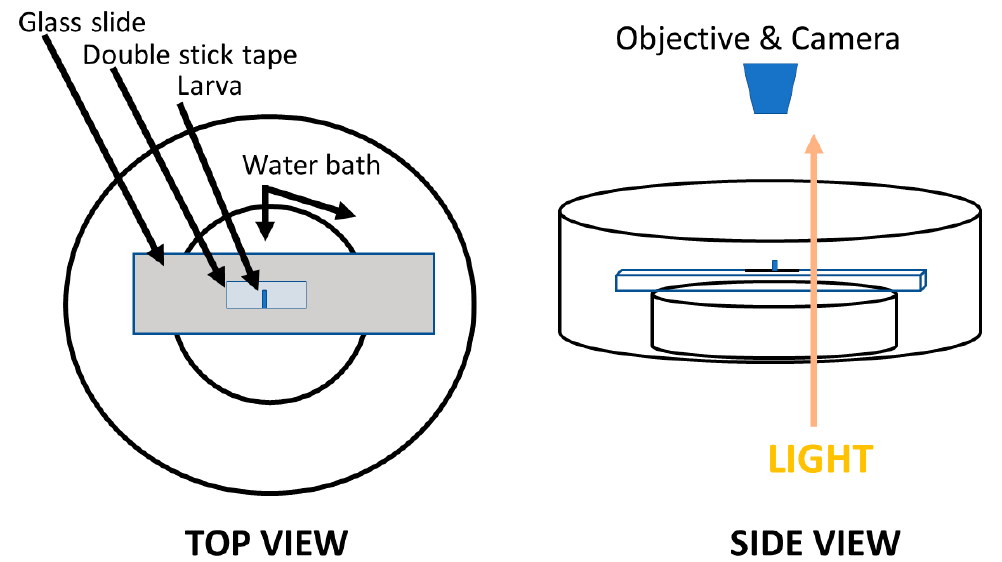
Figure 2. The protocol to observe heart beats in whole larvae. A larva was dried and placed onto double-stick tape with the dorsal aspect facing upward. The slide was placed on a glass Petri dish slightly smaller in diameter than the length of the slide. The smaller Petri dish was placed inside of a wider diameter glass Petri dish to catch spilled over water but also to aid in temperature control. The two dishes were adhered together with surgical wax which held well in a wet environment. The dishes were placed on a base of a microscope with a mirror which can project light through the dishes and onto the larvae.